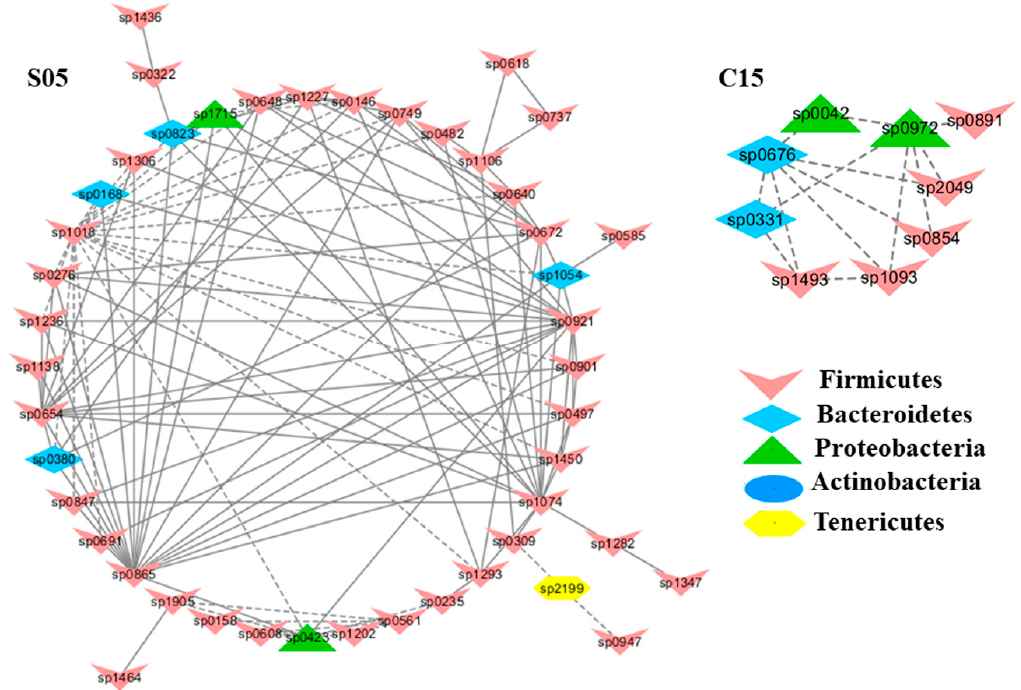
Figure 3. Modules C15 and S05 in the C and S network, respectively, showing a strong correlation with blood urea nitrogen levels (BUN). The detailed annotation of each OTU node can be found in Table S3.